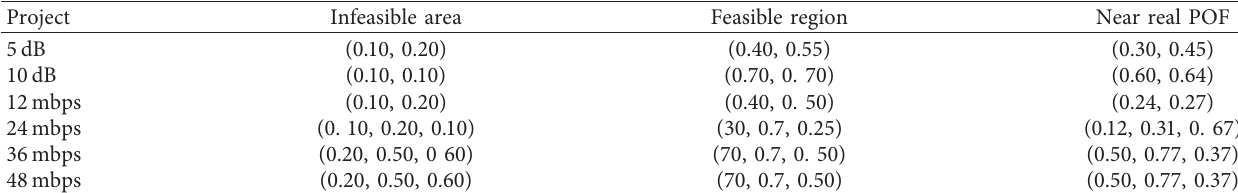
Table 6: Coding situation monitored by different transmission